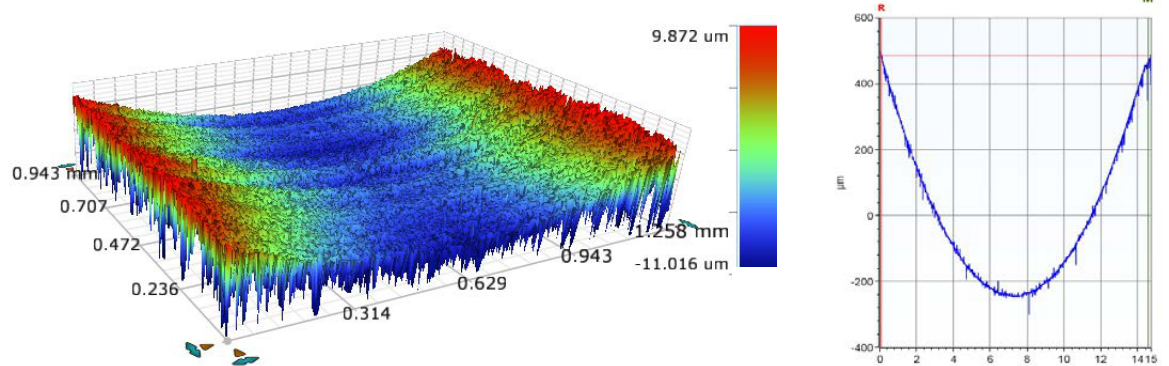
Figure 4. The 3D and 2D wear track profiles of sample number (S1) were obtained using a 3D optical profilometer. Table 2. Wear volume of the tested casing samples.